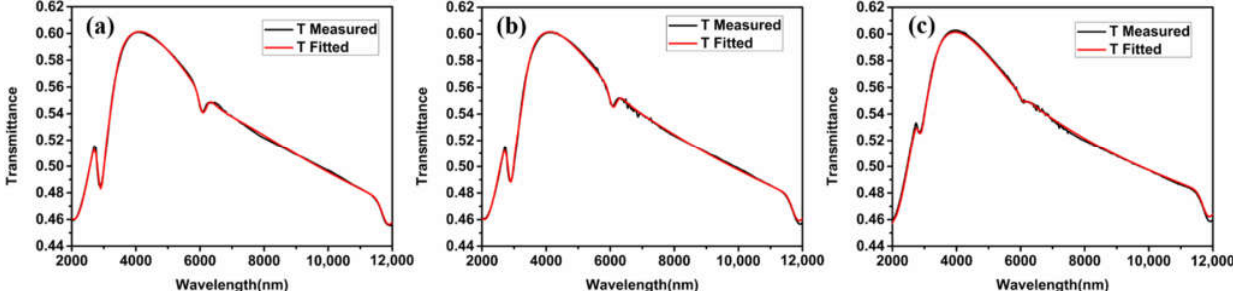
Figure 6. Fitting and measuring results of optical s pectra from 2000 nm to 12,000 nm of YbF 3 films prepared at different ion energies. ( a ) 0 eV. ( b ) 180 eV. ( c ) 360 eV.